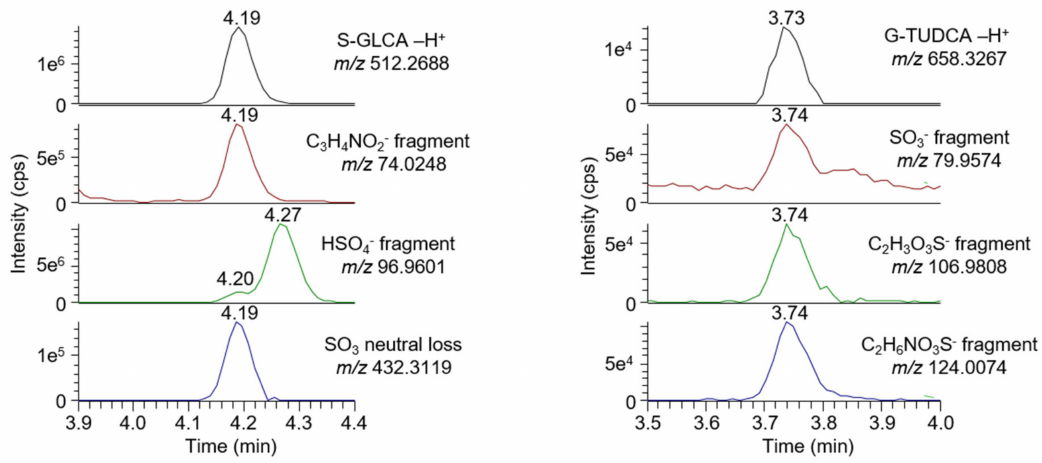
Figure 1. Chromatographic traces of S-GLCA ( left ) and G-TUDCA ( right ). The signal detected on the MS1-extracted chromatogram ( top ) co-eluted with characteristic fragments from the conjugated glycine and taurine, respectively.